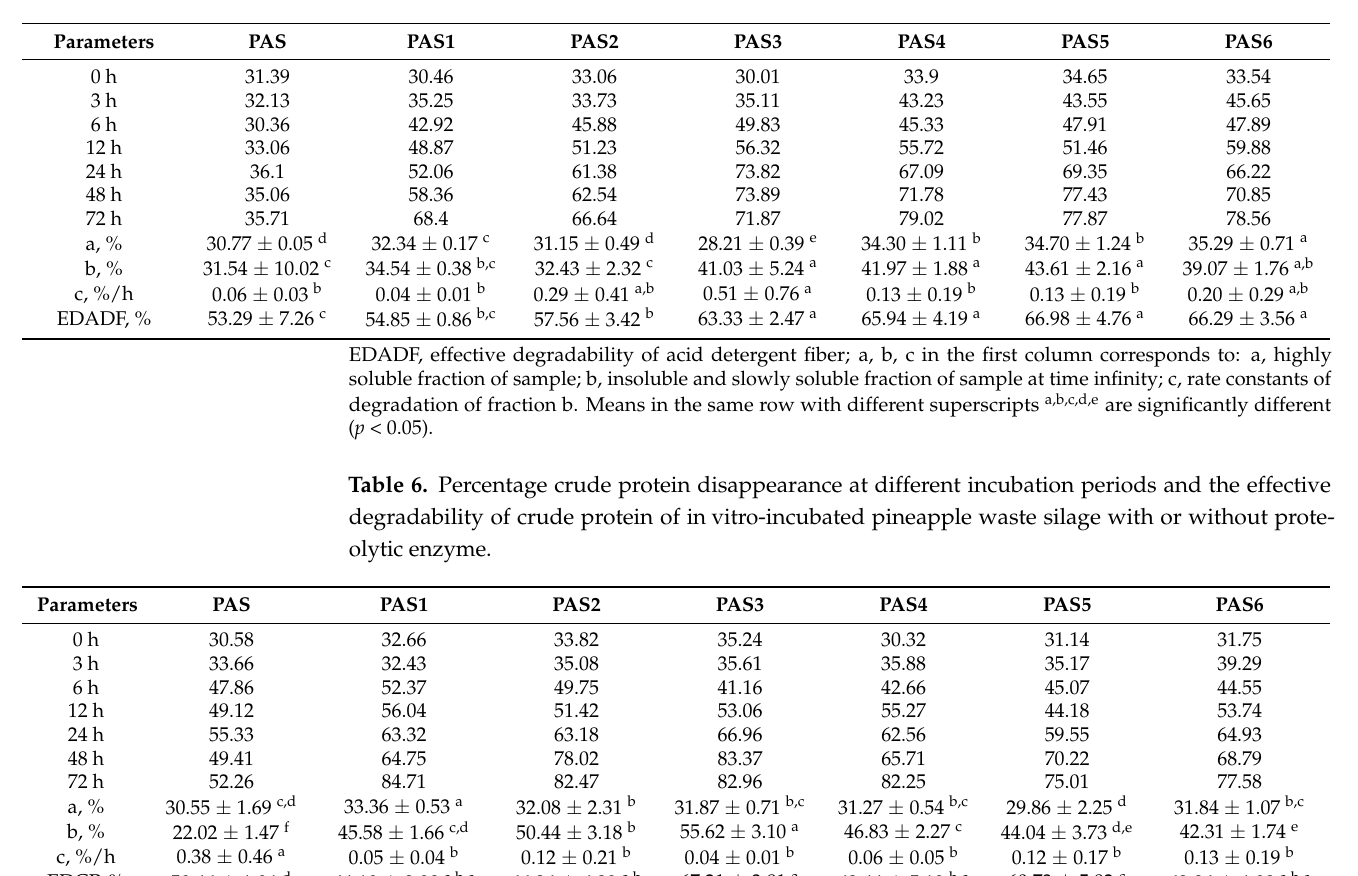
Table 5. Percentage acid detergent fiber (ADF) disappearance at different incubation periods and the effective degradability of acid detergent fiber of in vitro-incubated pineapple waste silage with or without proteolytic enzyme.